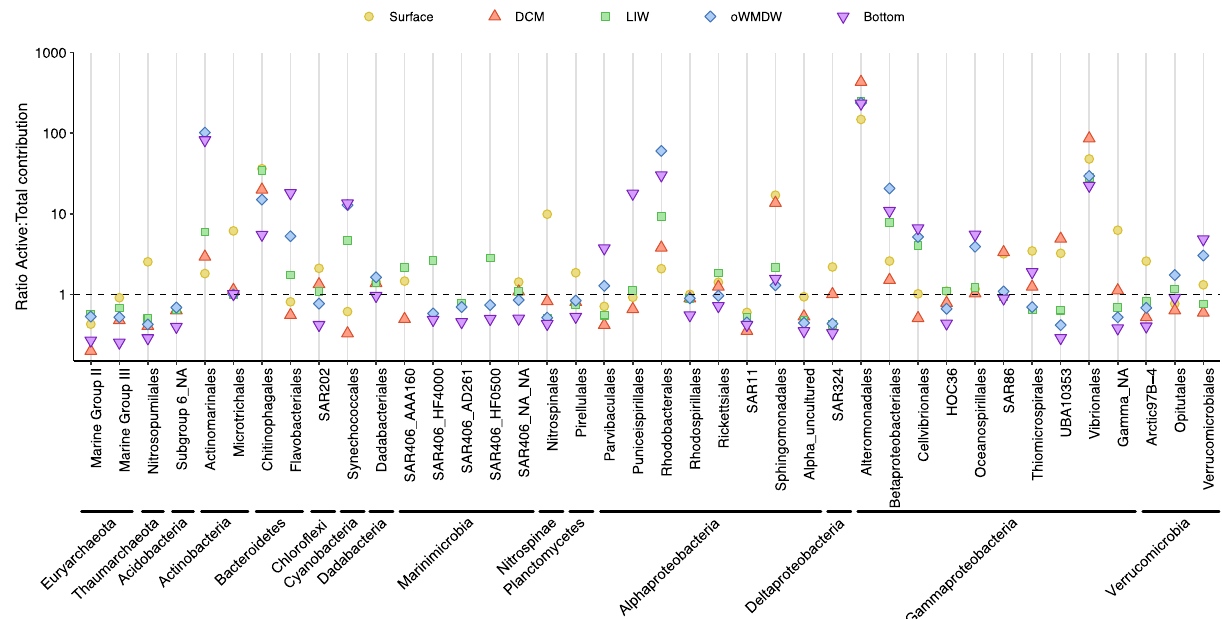
Figure 4. Actively dividing to total contribution ratio of phylotypes. Phylotypes at the Order level with ≥ 0.6% of abundance in at least one water mass are plotted. The different depth layers are depicted in different shapes and colours. Corresponding Phyla and Class (for Proteobacteria), are specified. Dashed line indicates ratio 1. DCM: deep chlorophyll maximum; LIW: Levantine intermediate water; oWMDW: old western Mediterranean deep water; NA: